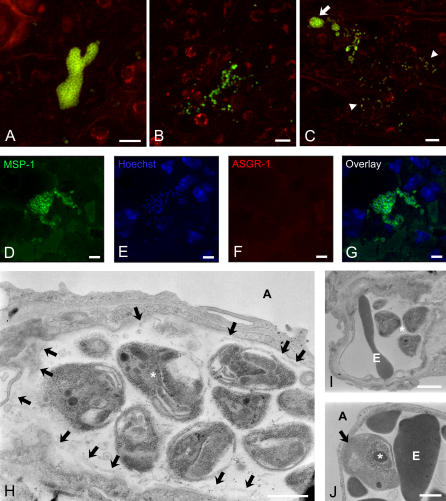
Merosomes Accumulate in the Lungs and Release Merozoites into the Pulmonary Microcirculation(A) Ex vivo confocal microscopy of a mouse lung 52 h after infection with PyGFP shows a large merosome located inside an alveolar capillary.(B) A group of individual merozoites inside pulmonary capillaries.(C) Small parasite aggregates and individual merozoites (arrowheads) fanning out in one direction from a merosome (arrow). This asymmetric parasite distribution suggests that merosomes release merozoites into the pulmonary microcirculation. (A–C) Bars = 10 μm.(D–G) Mouse lung fixed 52 h after infection with P. yoelii. The frozen section was immunolabeled with MSP-1 followed by protein A-FITC (D, green) indicating that the merozoites are intact. Labeling with goat-anti-ASGR-1 followed by rabbit anti-goat IgG-TX (E, red) revealed the absence of the receptor on the merosomal membrane. Nuclei were visualized by Hoechst staining (F, blue).(H) Electron micrograph showing well-preserved merozoites (∗) in the lumen of an alveolar capillary. Only fragments of the merosomal membrane are detectable (arrows). *, merozoite; A, alveolar lumen. Bar = 1 μm.(I) Free merozoites released into the lumen of a pulmonary capillary. *, merozoite; E, erythrocyte. Bar = 1 μm.(J) Alveolar capillary showing an erythrocyte (arrow) harboring a recently invaded merozoite in addition to several uninfected erythrocytes. *, merozoite; E, erythrocyte. Bar = 1 μm.